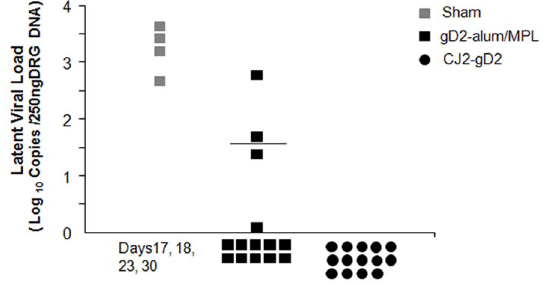
Figure 6. Protection from latent viral infection in guinea pigs immunized with CJ2-gD2. Sixty days after challenge with wild-type HSV-2, twelve lower lumbar and sacral dorsal root ganglia (DRG) per guinea pig were collected from all fourteen CJ2-gD2-immunized guinea pigs and the thirteen surviving gD2-alum/MPL-immunized guinea pigs. As a control, the DRG DNA was also isolated from four sham-immunized guinea pigs euthanized on days 17, 18, 23, and 30 post-challenge, respectively, due to the severity of local and systemic illness caused by HSV-2 infection. The total DNA was extracted and the presence of latent viral DNA was quantified by quantitative real-time PCR. The HSV-2 genome number per guinea pig was determined and presented as mean value. The guinea pig showing the highest viral DNA load in gD2- alum/MPL group was the one euthanized on day 35 post-challenge.